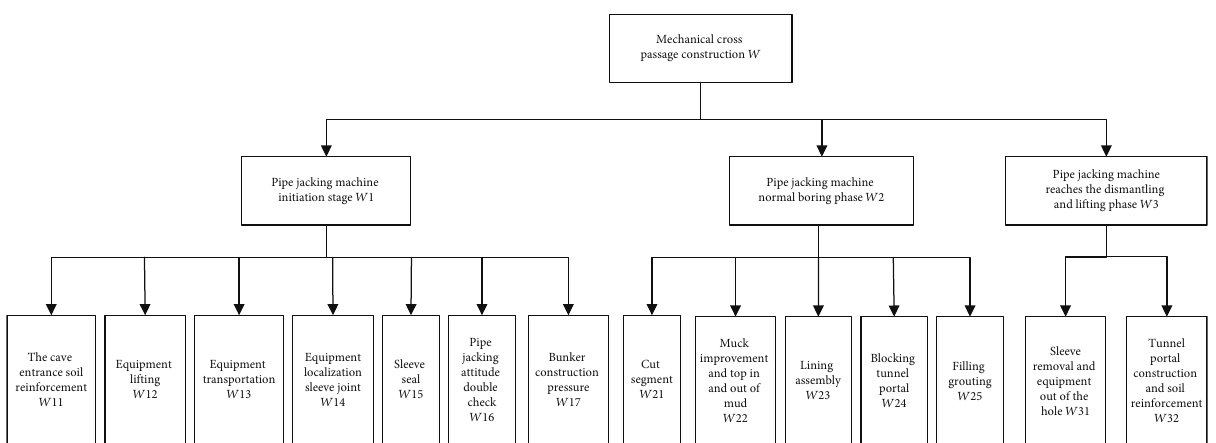
Figure 5: Work breakdown of the connecting aisle.